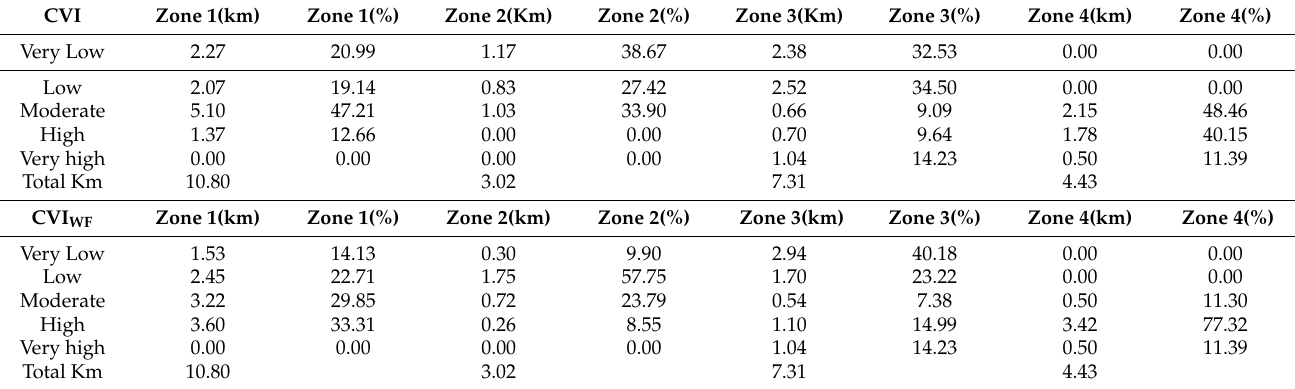
research area with the CVI and CVI WF applications is also presented in Figure 7. Table 4. CVI and CVI WF results in Zones 1–4 of the research Table 4. CVI and CVI WF results in Zones 1–4 of the research area.